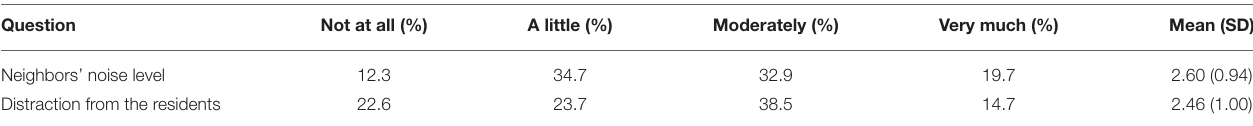
TABLE 7 | List of the missed musical activities and the ratio of people who answered “yes.” Activity Ratio (%) Outdoor festivals Taking lessons